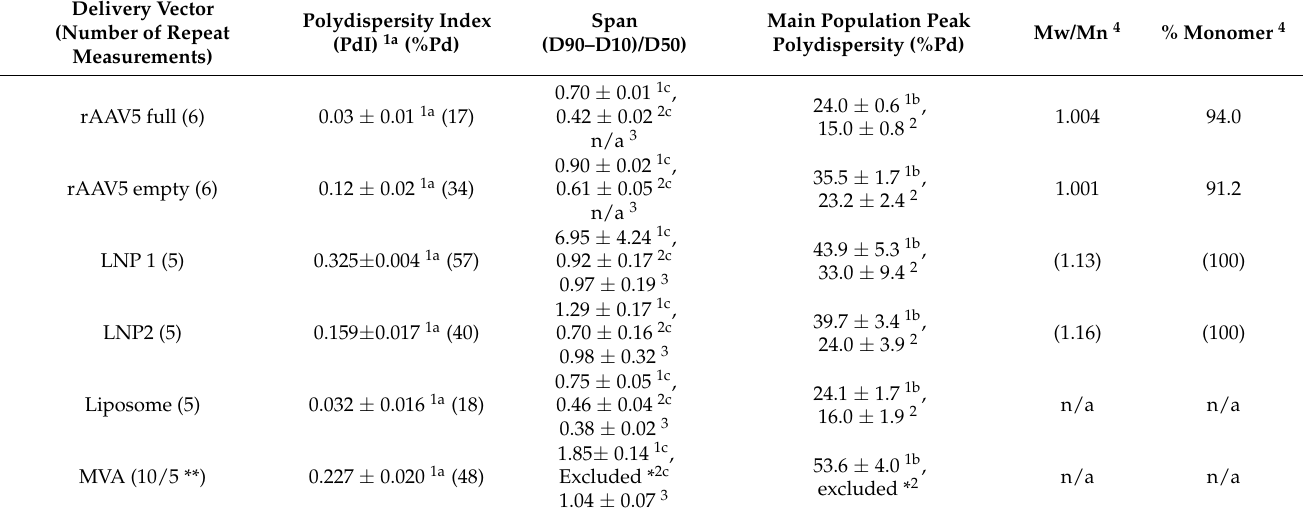
Table 6. Polydispersity of delivery vectors determined by DLS, MADLS, SEC-SLS and NTA. Some of the parameters are specific for the analytical technique, with some techniques using the same way of calculating sample polydispersity. n/a indicates where data is not available. * For the MVA sample, where it was determined that the MADLS data only captured the top end of the sample distribution, the MADLS polydispersity data have been excluded. For the other techniques, the main peak is considered to be the peak around 200 nm in diameter. The span is calculated from the 90th, 50th and 10th percentiles of the size distribution, using either NIBS (volume transformation), MADLS or